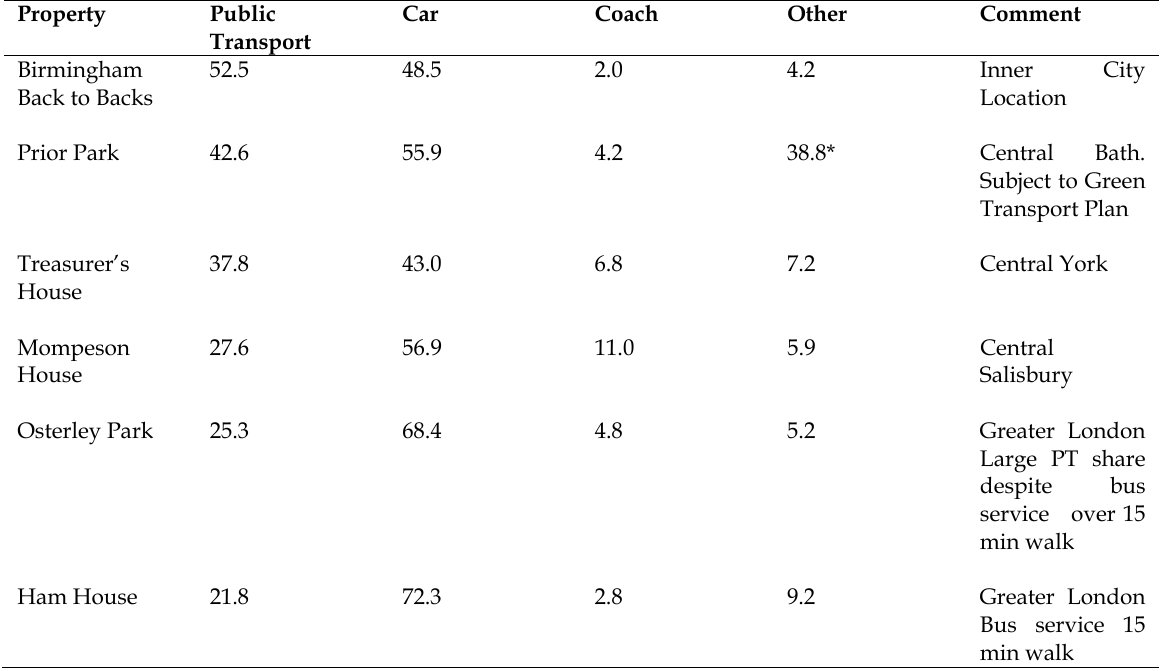
Table 7. Properties with a high percentage of arrivals by public transport